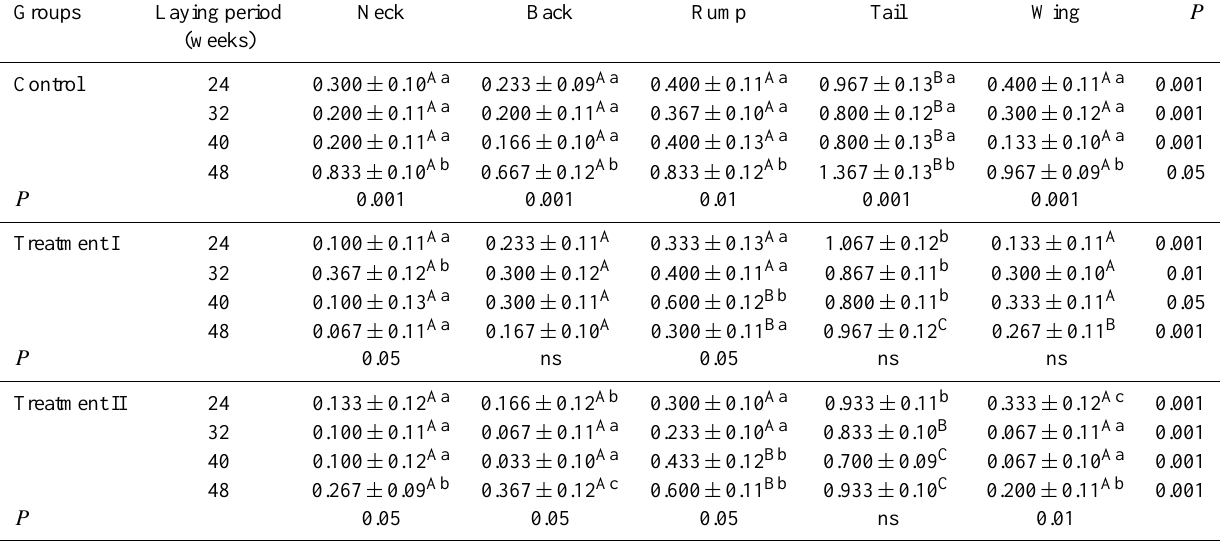
Table 3. Average feather score for all body regions of the birds in each group. Groups